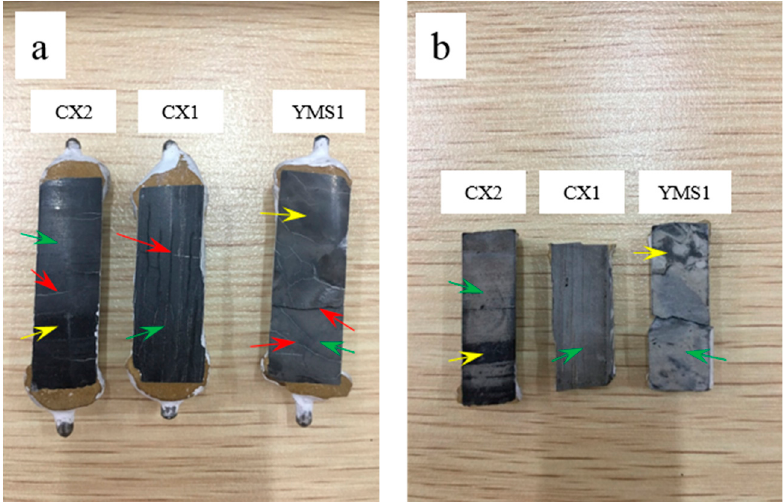
Figure 8. Rock prisms cracks and erosion surface cured in TMAH solution for 154 days: ( a ) before erosion, ( b ) after erosion.